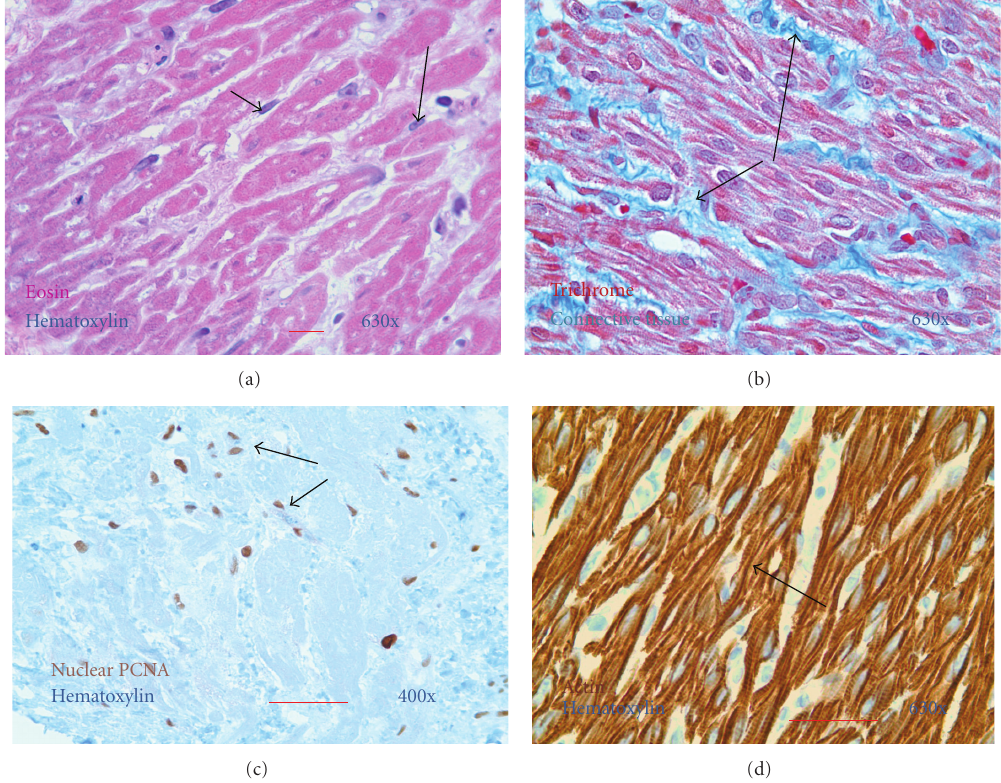
Figure 5: Characterization of cardiac tissue after SEC. Representative photomicrographs of tissue sections of formalin-fixed para ffi n- embedded atrial tissue. The atrial appendage from a patient with end-stage heart failure was removed at the time of heart transplantation and cultured for 28 days using the SEC method. (a) Day 28 tissue explant stained with hematoxylin (blue) and eosin (red). Note preserved cardiomyocyte morphology and small nucleated interstitial cells (arrows). Magnification × 630. (b) Day 28 tissue explant stained with Trichrome. Note, a modest increase in interstitial connective tissue (blue; arrows). Magnification × 630. (c) Day 28 tissue explant immunostained to demonstrate proliferating interstitial nucleated cells. Proliferating cell nuclear antigen/PCNA positive cells are brown (DAB) with hematoxylin counterstain (blue). Magnification × 400. (d) Day 28 tissue explant immunostained for muscle-specific actin are brown (DAB) and hematoxylin counterstain (blue). Note conservation of the myocellular contractile elements with visible cross-striations (arrow). Magnification ×